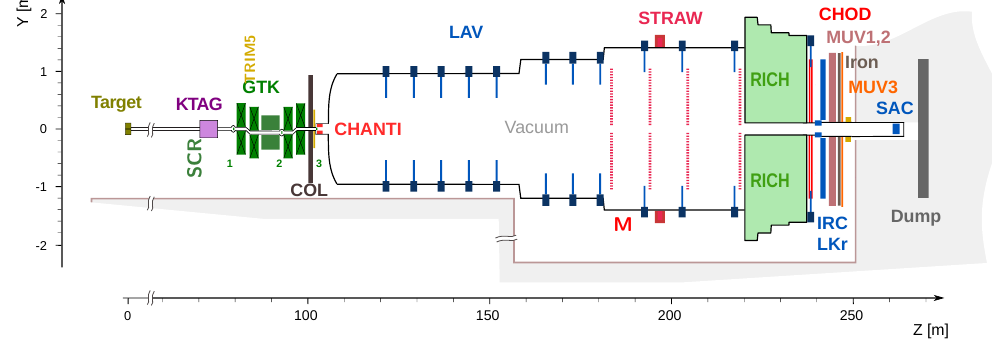
Figure 1 . Schematic side view of the NA62